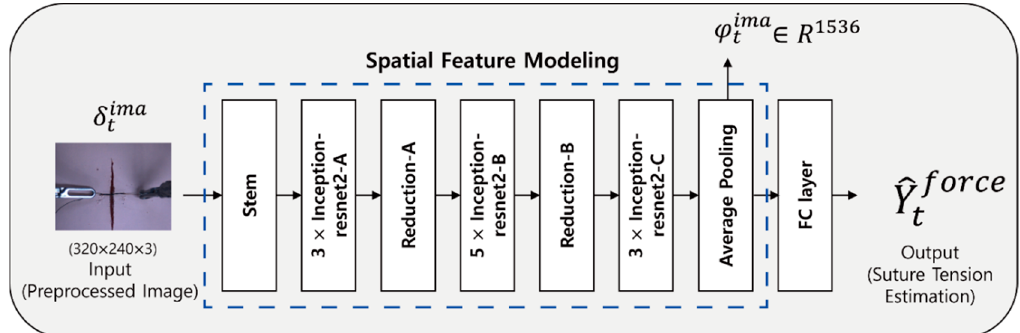
Figure 4. Spatial Feature Modeling structure. Inception-ResnetV2 network is used to obtain the spatial feature vector. This network consists of Stem, 3× Inception-resnet2-A, Reduction-A, 5× Inception-resnet2-B, Reduction-B, 3× Inception-resnet2- C, average pooling and FC layer modules. At test time, feature vector 𝜑 (cid:3047)(cid:3036)(cid:3040)(cid:3028) is extracted from the average pooling.